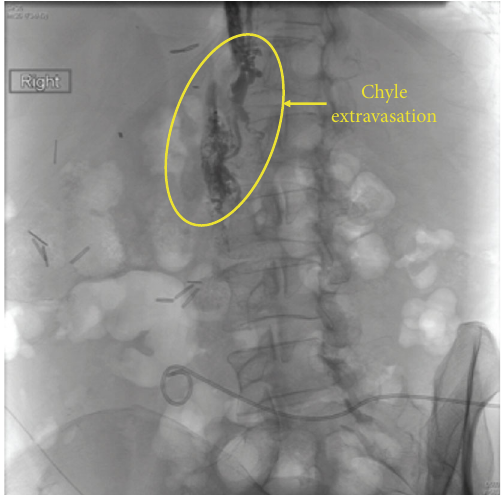
Figure 3: Representative image showing chyle leak interrogated during lymphangiogram. This was embolized but did not signi fi cantly improve the patient ’ s